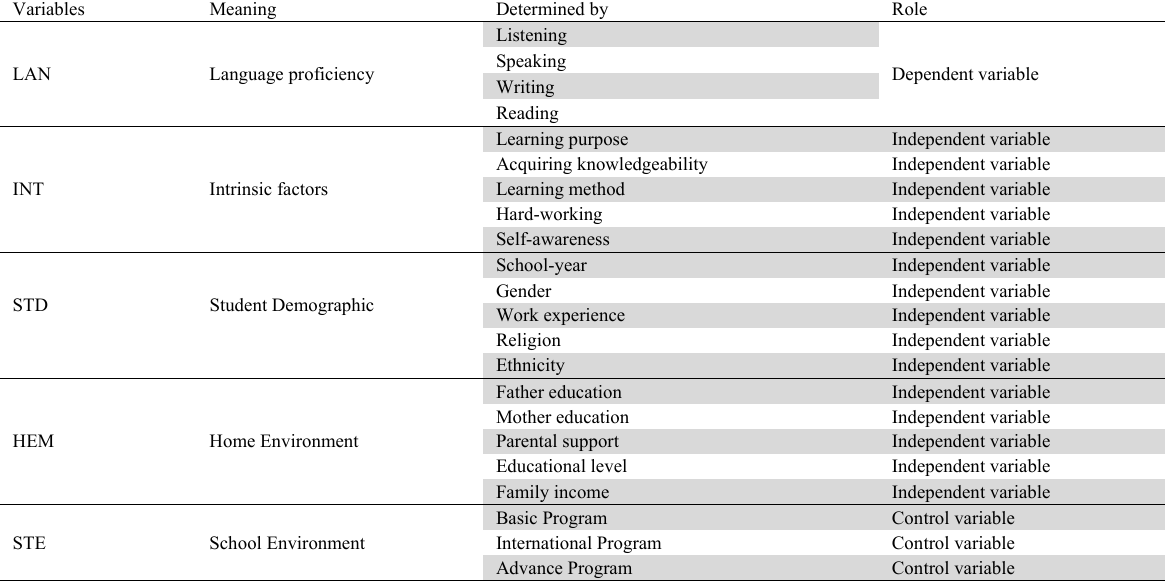
List of dependents, independent and control variables of the regression models